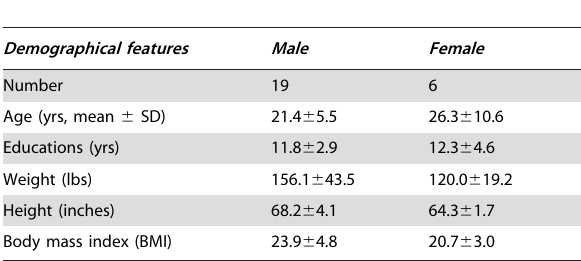
Table 1. Subject characteristics of first-episode neuroleptic- naı¨ve patients with